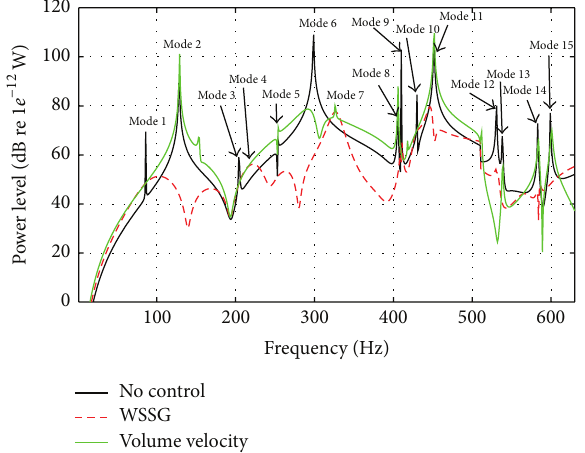
Figure 9: Sound radiated by the second radiation mode on the clamped rectangular plate.